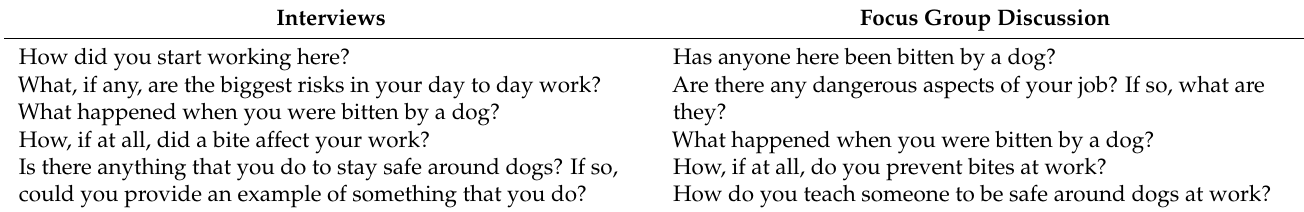
Table 1. Example of interview and focus group discussion questions used.